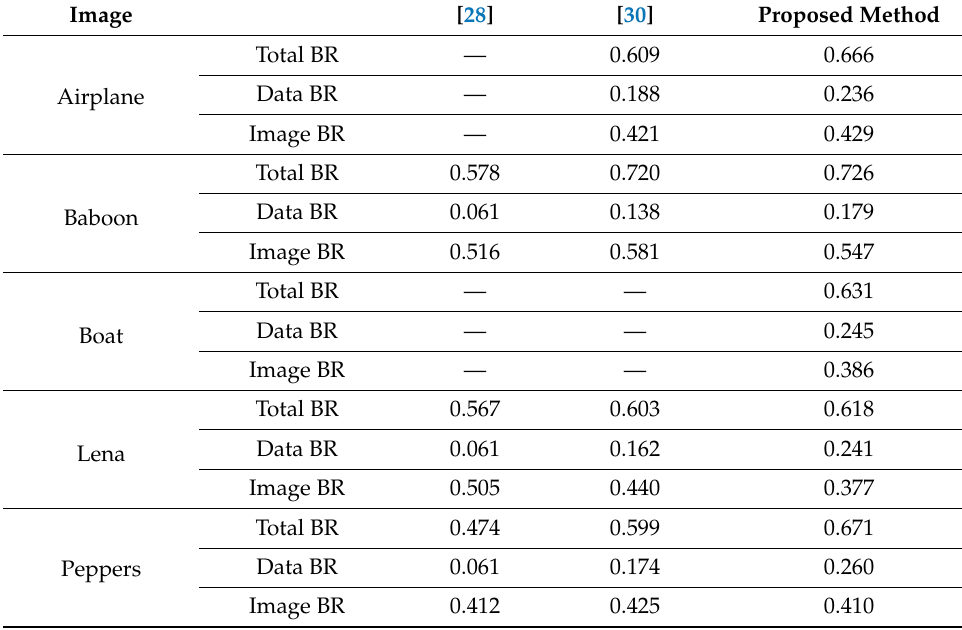
Table 6. Total bitrate, data bitrate, and image bitrate of de-clustering schemes.